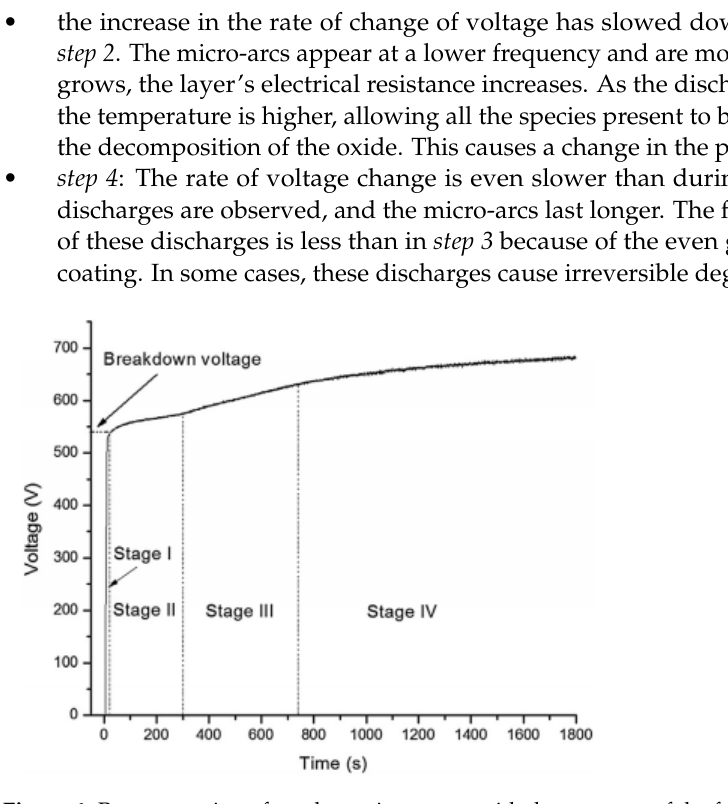
Figure 4. Representation of a voltage-time curve with the presence of the four stages observed during the process of MAO